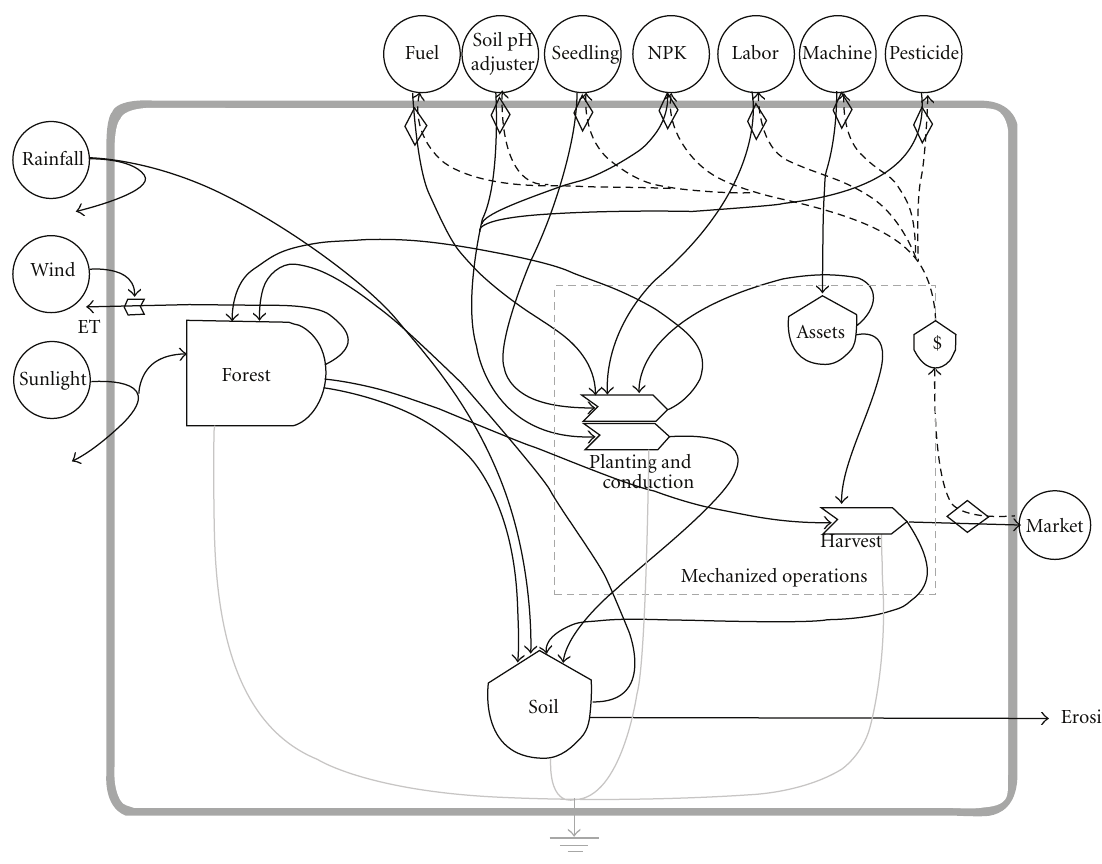
Figure 3: Systems diagram for Eucalyptus production